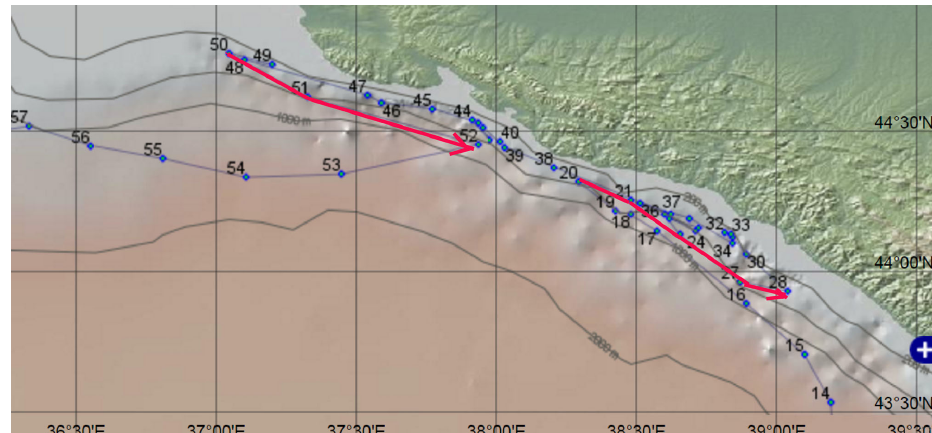
Figure 8. The trajectory of ARGO float No. 6901833 (station points with numbers) offshore the North Caucasus coast in the period 07 August 2016–10 March 2017. Red arrows mark undercurrents